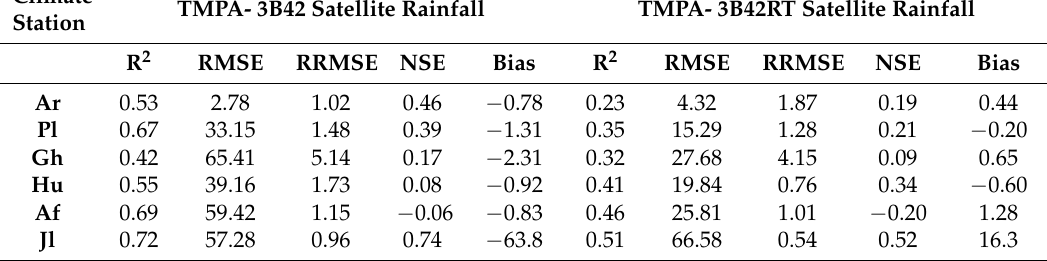
Table 8. Performance measures for SWAT-predicted runoff with the two TRMM-TMPA- predicted rainfalls. Climate